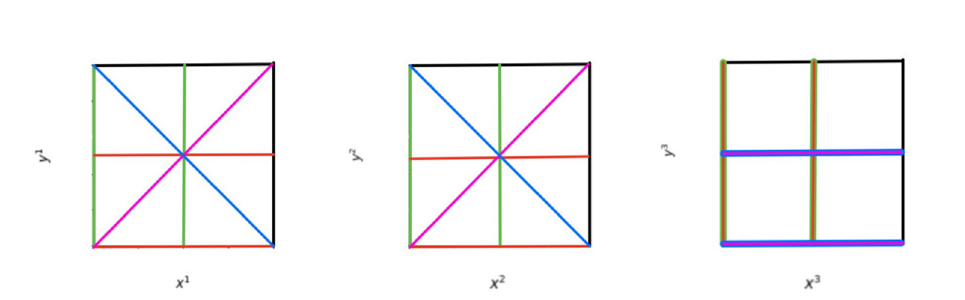
Table 2. O6-planes in T 6 / Z 4 .